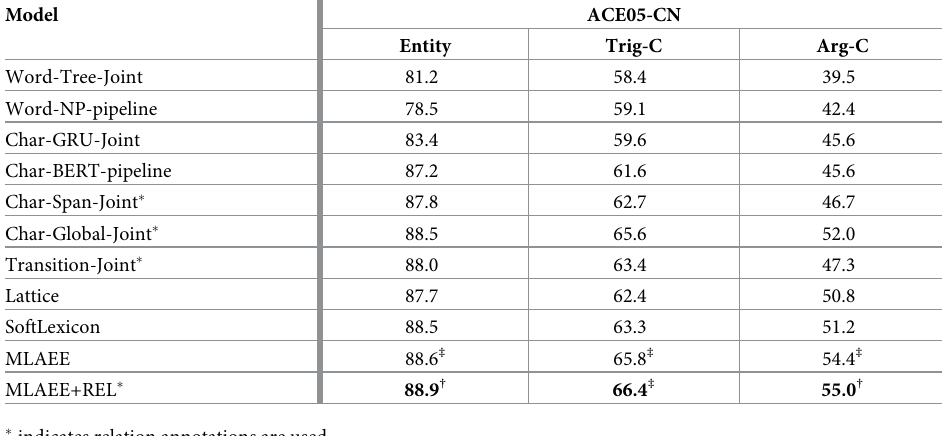
Table 1. Comparison results on ACE05-CN.